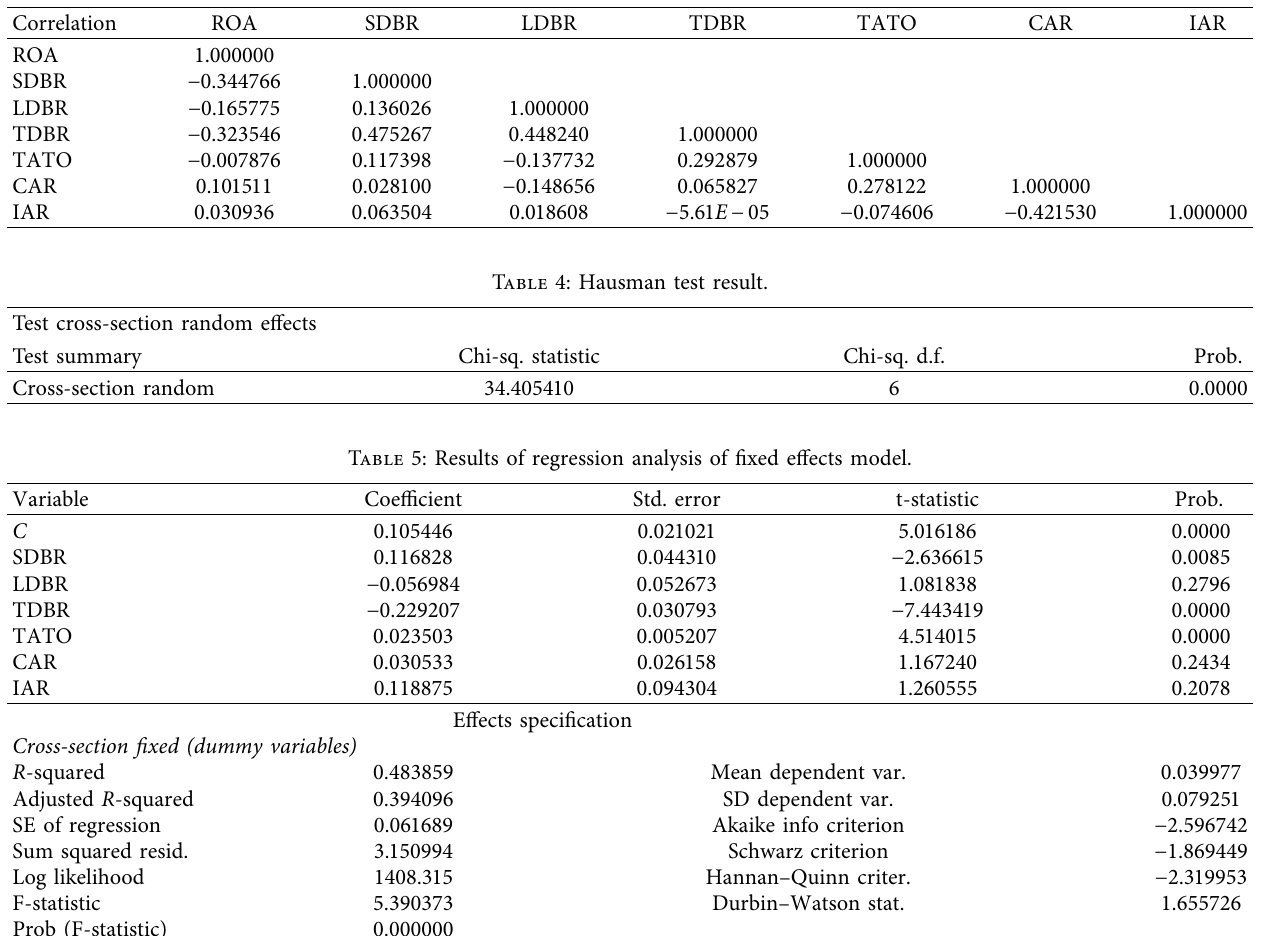
Table 3: Variable correlation analysis.